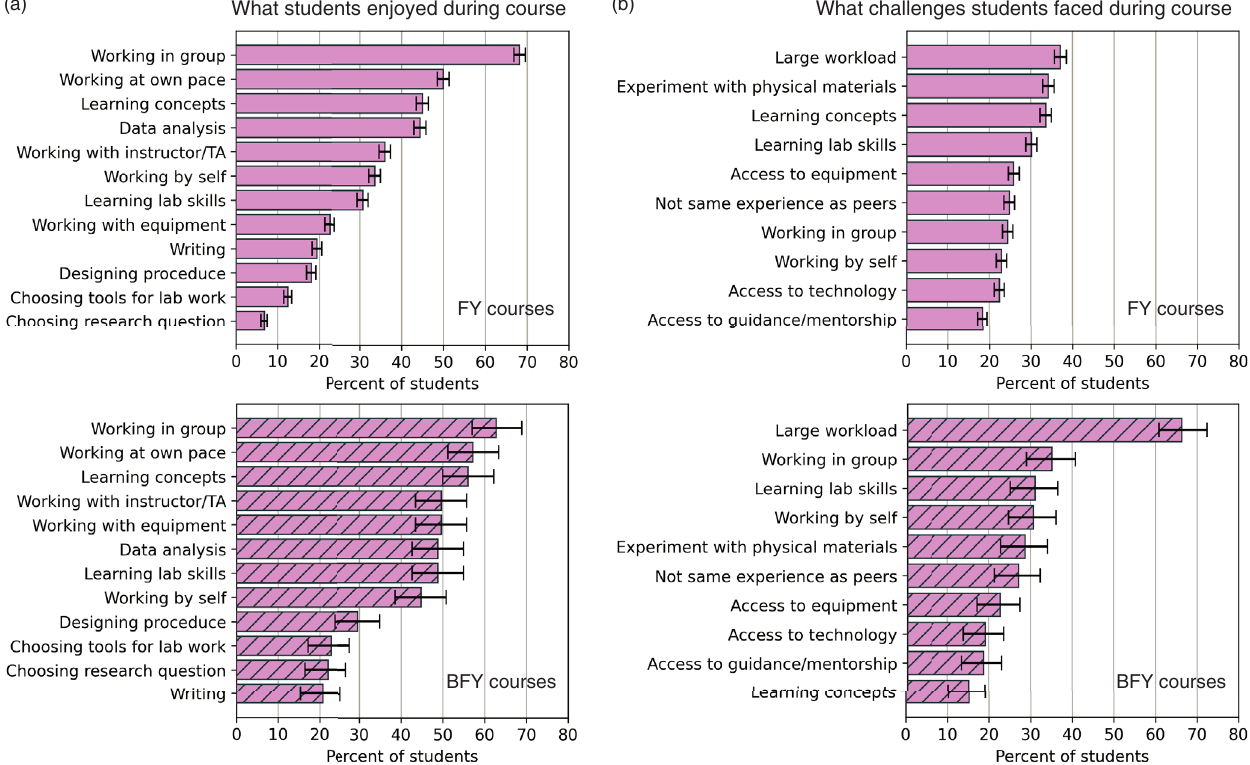
FIG. 6. Aspects of the course (a) enjoyed and (b) found challenging by the students. Challenges include only those relevant for remote courses. Percentages are of students in FY (plain, N ¼ 4565 ) and BFY (hatched, N ¼ 250 ) courses and error bars show the 95% confidence